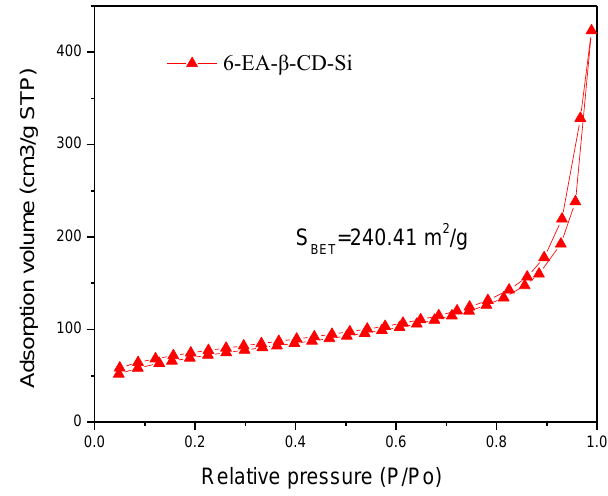
Figure 5. Brunauer-Emmett-Teller (BET) surface area of 6-EA-β-CD-Si. Table 1. Micro-structure data of β-CD, 6-EA-β-CD, Cl-Si, and 6-EA-β-CD-Si. Material BET Surface Area (m 2